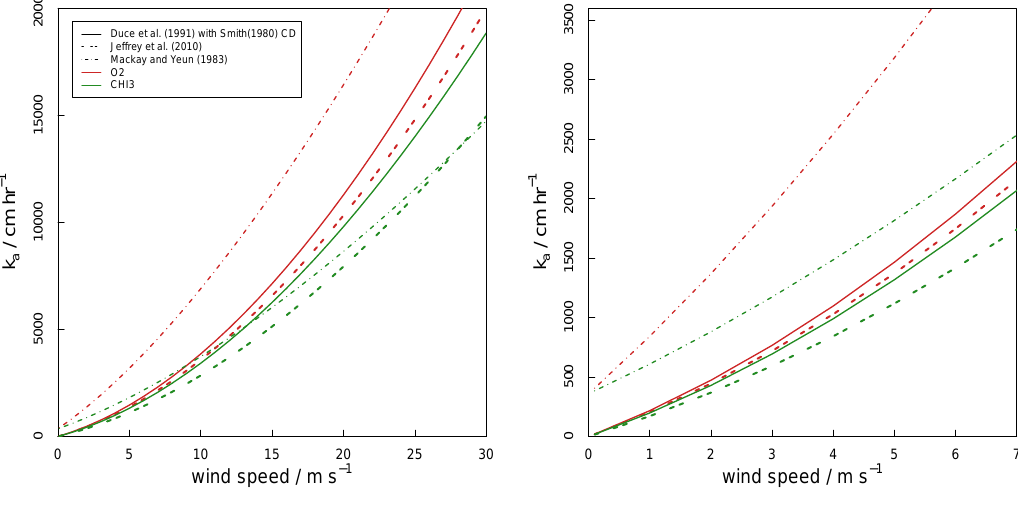
Fig. 3. Comparison of the Duce et al. (1991) k a parameterization with that of Jeffery et al. (2010) for CH 3 I and O 2 , both using the Smith (1980) drag coefficient parameterization. The empirical parameterization of Mackay and Yeun (1983) is included for comparison and to demonstrate that, whilst the two physically based parameterizations generally agree very well, Duce et al. (1991) particularly appears to underestimate the degree to which the Schmidt number affects the transfer velocity for different gases.